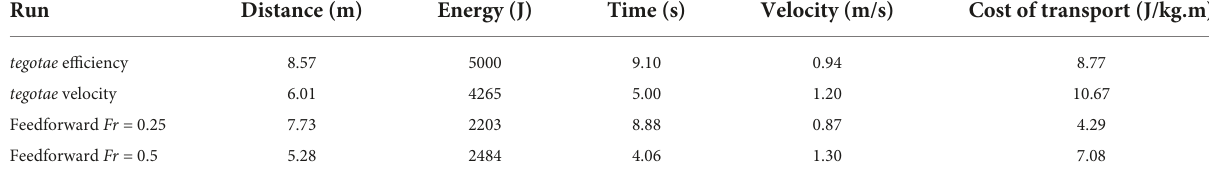
see that whilst the new controllers allow steady-state gait to be produced, their performance is worse than that achieved by